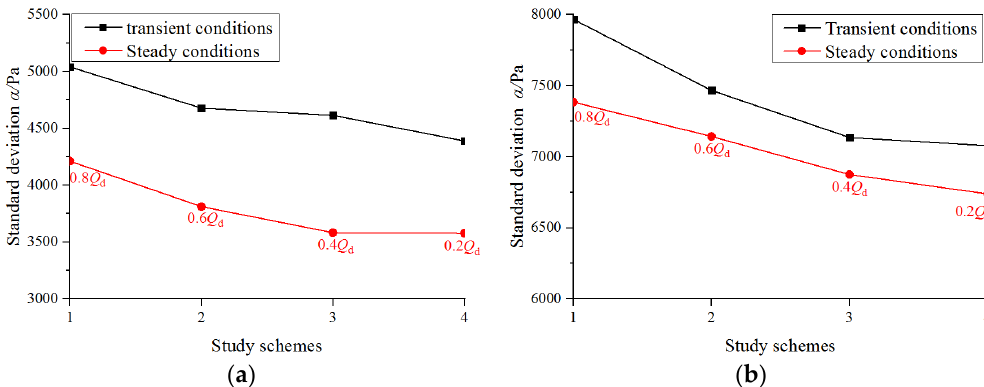
Figure 6. The standard deviation of dynamic pressure of transient and steady condition s at ( a ) P1 and ( b ) P2.